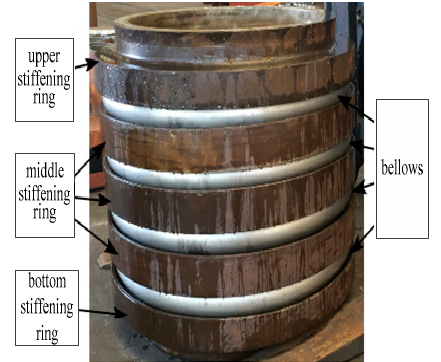
Figure 13. Formed expansion joint.